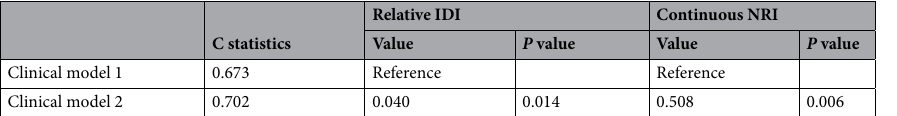
Table 4. Comparison of discriminant and reclassification capacities of each model for predicting primary MACE. Two predictive models were constructed as follows: Clinical model 1 included HbA1c, dyslipidemia, SYNTAX score ≥ 23; and Clinical model 2 included a combination of Clinical model 1 and